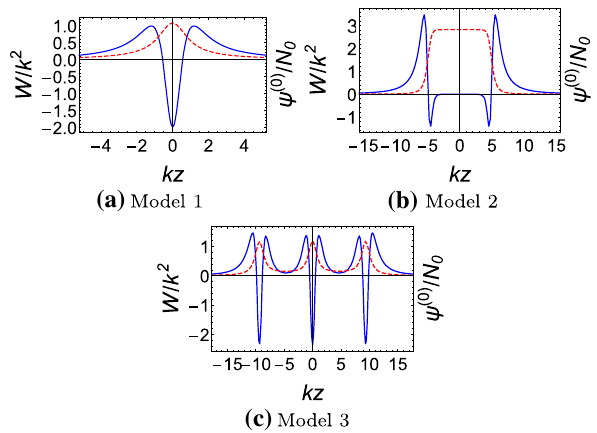
Fig. 8 The effective potentials (the blue lines) and the corresponding graviton zero modes (the red dashed lines) for the three models. For model 1, we set v = 1 and k 2 α = 0 . 01; for model 2, v = 1, kb = 10, and k 2 α = 0 . 006; and for model 3, v = 1, kb = 5, and k 2 α = 0 . 02